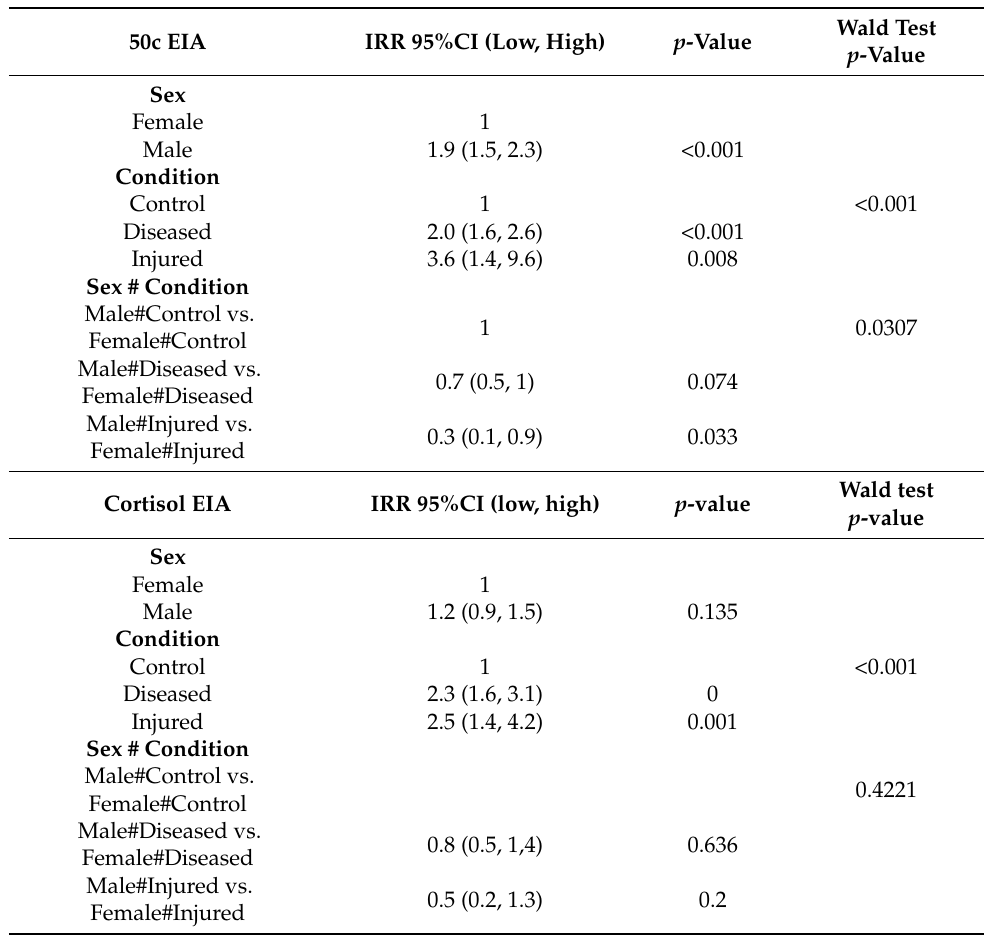
Table A7. Multivariate analysis of FCMs (faecal cortisol metabolites) for females and males and interaction with the three conditions (control, diseased and injured) measured with 50c and cortisol EIA (enzyme